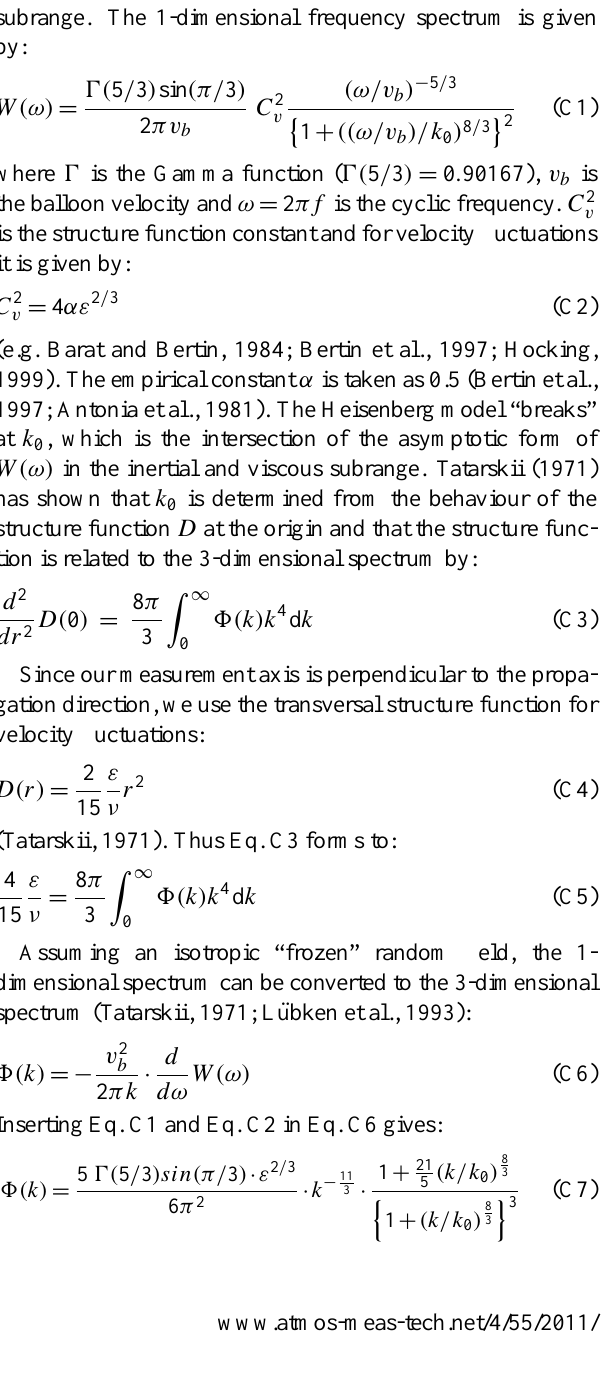
Fig. B1. Knudsen number for the vacuum test and for the BEXUS 6 flight.